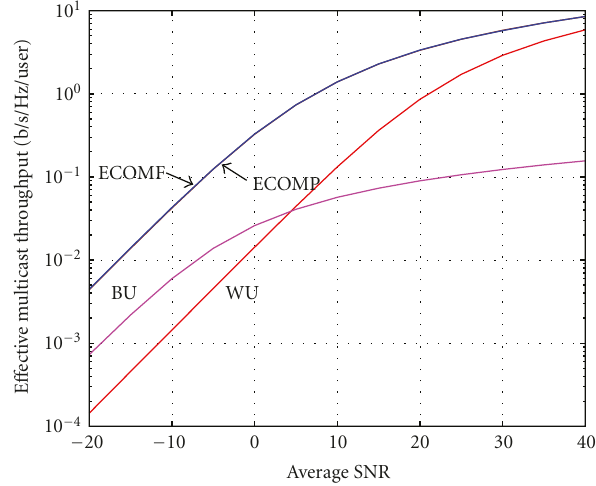
Figure 5: Convergence of N (cid:7) /N to e − ρ th (Rayleigh fading channel with average SNR of 0 dB).